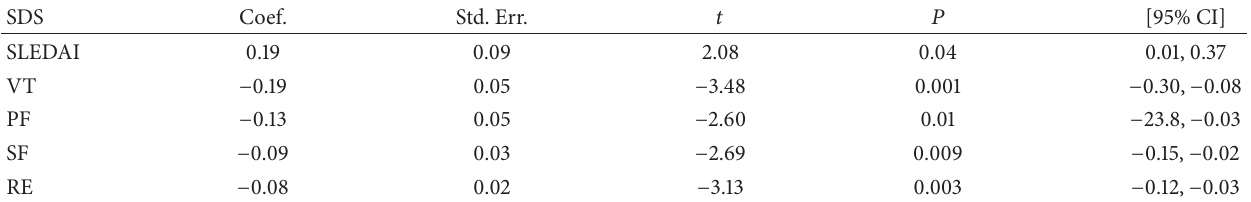
Table 5: Stepwise regression analyses of medical and psychological variables and their relationship to SDS in SLE patients. SDS Coef. Std. Err. 𝑡 𝑃 [95% CI] SLEDAI 0.19 0.09 2.08 0.04 0.01, 0.37 VT − 0.19 0.05 − 3.48 0.001 − 0.30, − 0.08 PF − 0.13 0.05 − 2.60 0.01 − 23.8, − 0.03 SF − 0.09 0.03 − 2.69 0.009 − 0.15, − 0.02 RE − 0.08 0.02 − 3.13 0.003 − 0.12, −